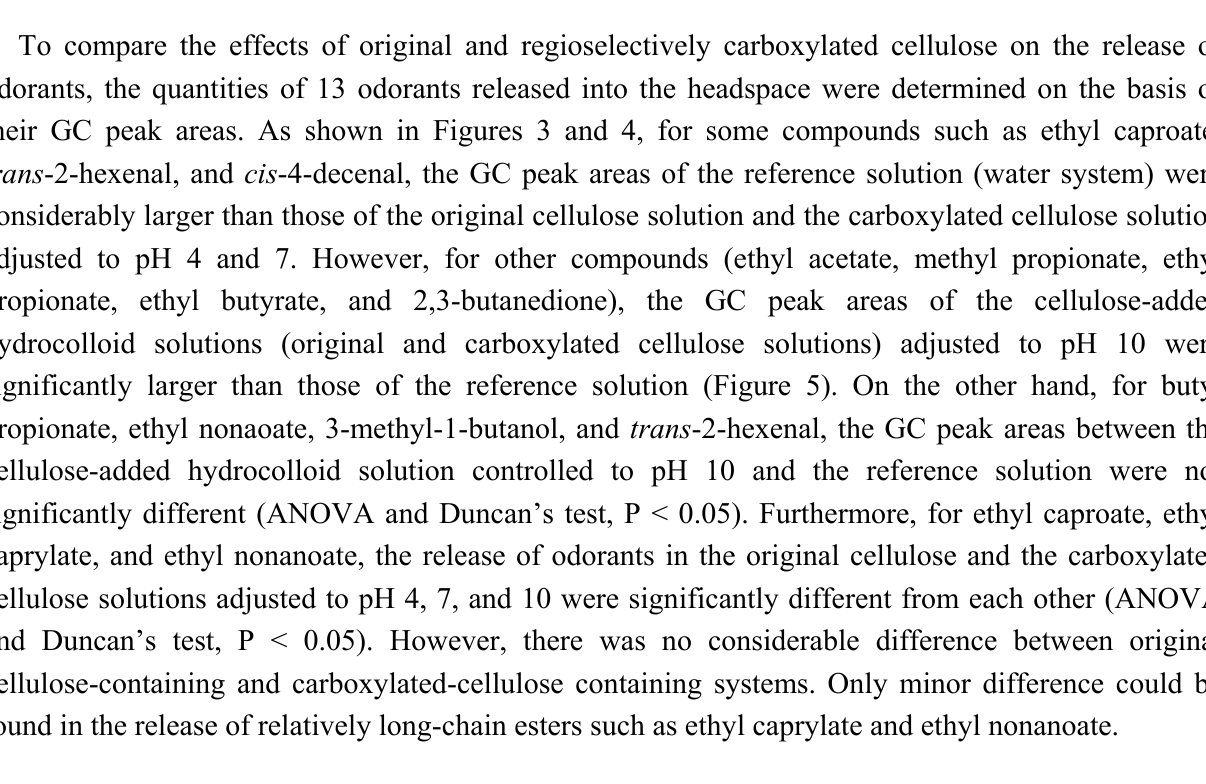
Figure 2. IR spectra of original cellulose ( a ) and carboxylated cellulose ( b